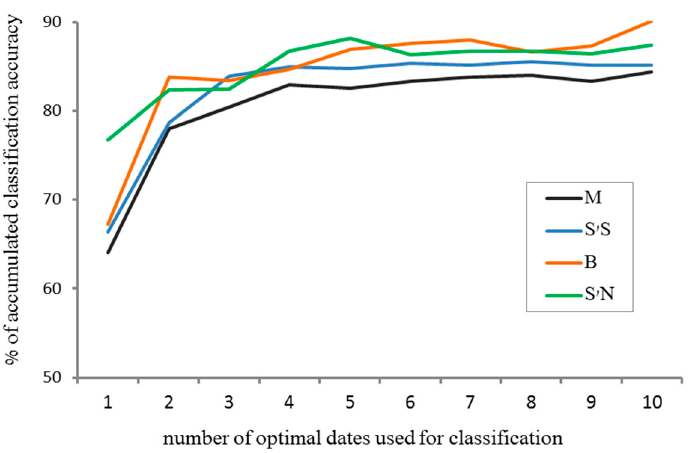
Figure 7. Total classification accuracy of the near-surface time series for all four sites. The classification was carried out by RF classifier, using all spectral indices (S ′ S— 708 individuals, 11 species; S ′ N—279 individuals, ten species; M—551 individuals, 11 species; B—314 individuals, nine species).